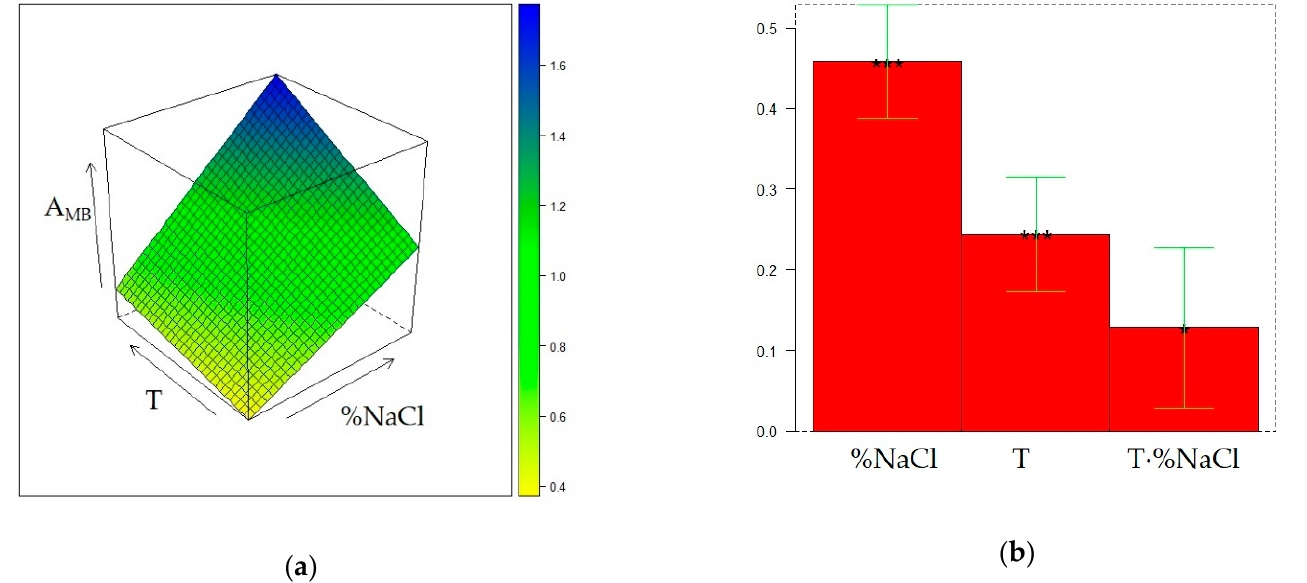
Figure 3. Optimization of HS-SPME collection of wine volatile profiles with the PDMS fiber: ( a ) response surface for the peak area of 3-methyl-1-butanol (A MB ); ( b ) coefficients of the surface model; p < 0.05 (*), p < 0.001(***).